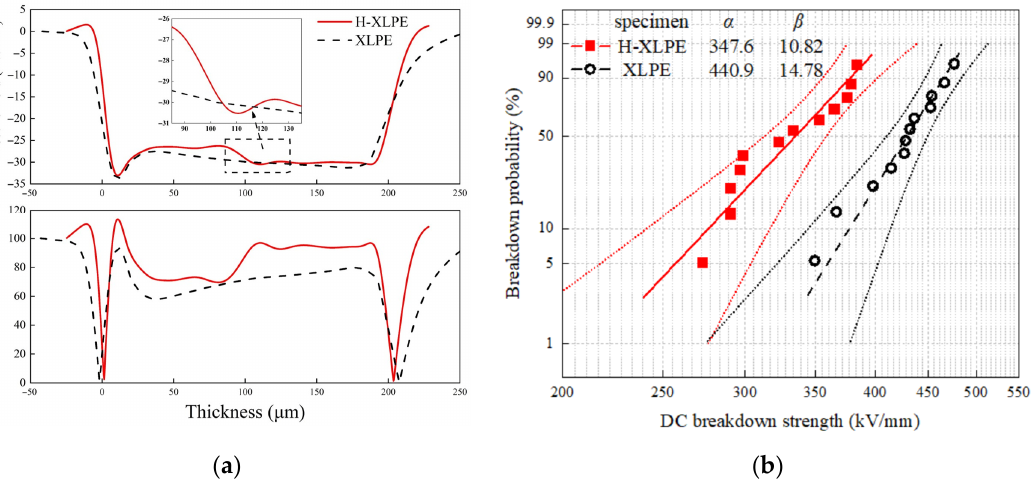
Figure 3. Effect of charge accumulation: ( a ) electric field distribution (upper panel) and distortion rate (lower panel); ( b ) Weibull distribution of DC breakdown strength.